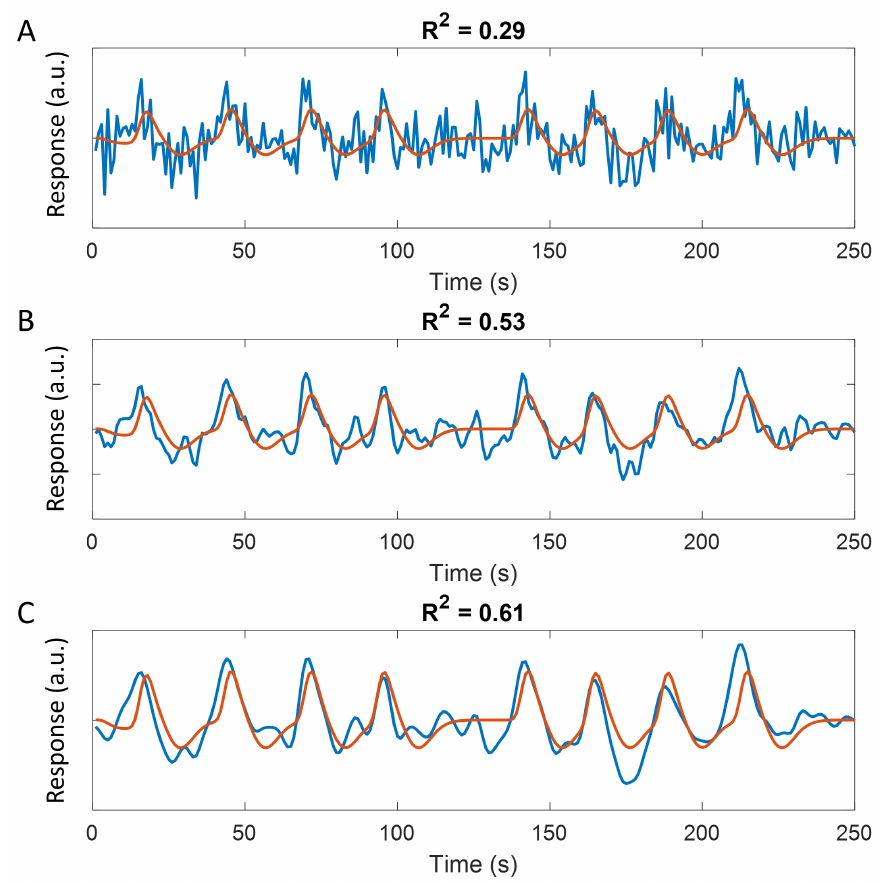
Figure 1. Low-pass filtering the time series improves goodness-of-fit quantified by R 2 . The same predicted time series (red curves) is shown overlaid on the unfiltered time series ( A ), and low-pass filtered time series with kernel 1 s ( B ) or 2 s ( C ). R 2 is substantially larger for the filtered time series because high-frequency noise has been removed.